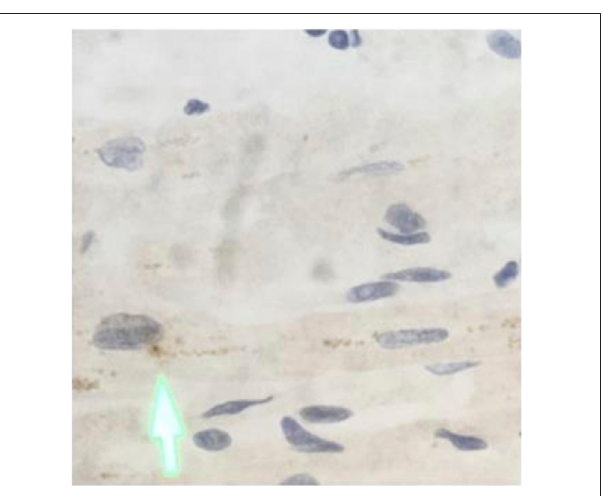
FIGURE 7 | Immunohistochemical analysis in myocardium from the autopsyofpatientwhodiedsecondary toCOVID-19infection (A) SARS-CoV- 2 is positive (arrow) in the myocardial tissue, original magni fi cations × 400.